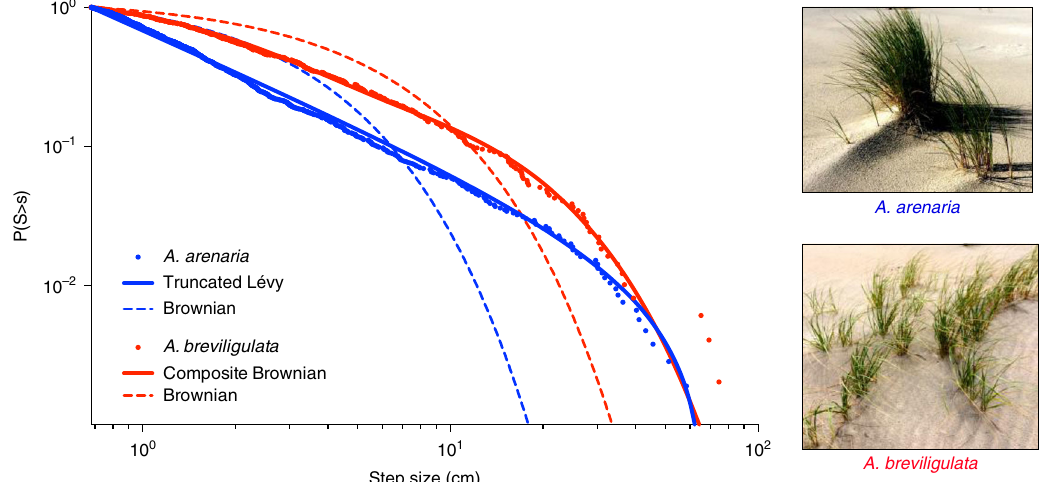
Fig. 2 The clonal expansion strategy of both Ammophila species. Inverse cumulative frequency distribution of the pooled step size data (step size >0.68 cm) obtained for both Ammophila arenaria (1053 steps from eight individual plants) and Ammophila breviligulata (492 steps from four individual plants). The dashed lines represent the best- fi tted exponential distribution (Brownian) for A. arenaria (blue) and A. breviligulata (red), respectively. The best fi t for the total data set, based on weighted AIC value (see Supplementary Table 1), was a truncated Lévy (blue line) for A. arenaria and a two-mode Composite Brownian (red line) for A. breviligulata . Source data are provided as a Source Data fi